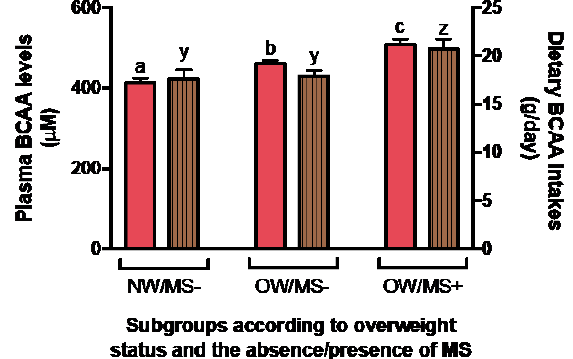
Figure 1. Mean plasma and dietary BCAA levels between subgroups of NW/OW individuals with or without MS. Plasma BCAA levels are shown in plain salmon; BCAA intakes calculated from food frequency questionnaire are shown in lined brown. Whiskers represent standard error. Results who do not share the same letter ( a,b,c for plasma BCAA levels and y,z for dietary BCAA intakes) are significantly different ( p < 0.05) from each other. Values presented are unadjusted.